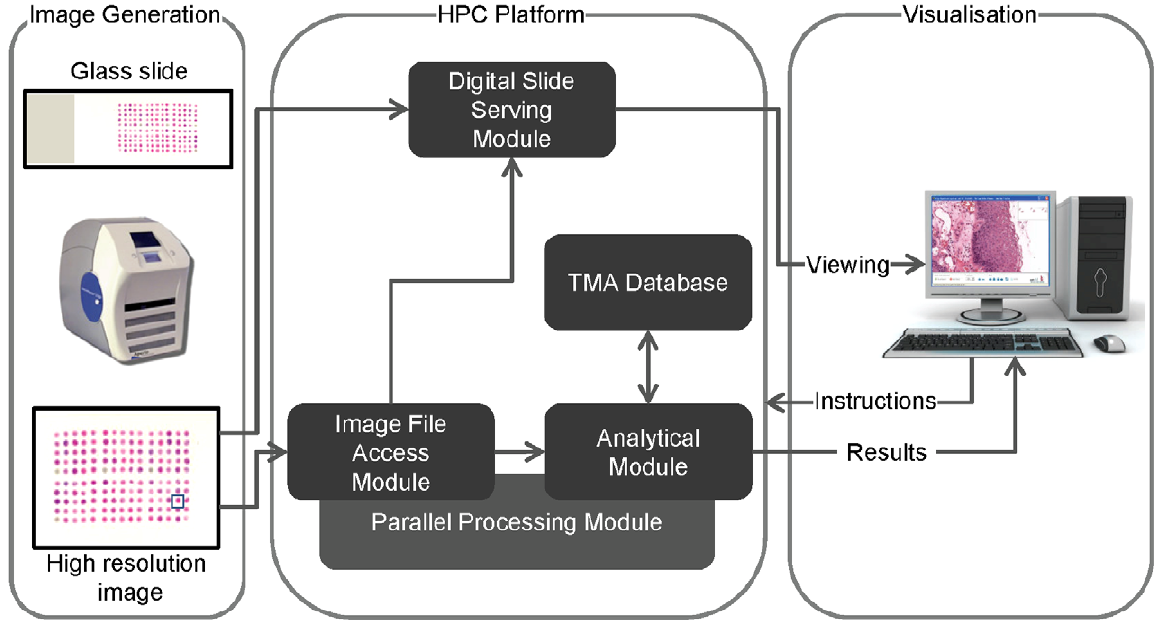
Fig. 1. System architecture of the HPC Platform for TMA Analysis. Image Generation (left) utilises scanning technology to generate high resolu- tion images of the glass TMA slide. This is utilised within the HPC Platform (centre) which comprises a number of interacting functional modules. Visualisation (right) of imagery and data generated from HPC analysis can be achieved remotely used web-based technology based on PathXL platform (i-Path Diagnostics Ltd.). (Colours are visible in the online version of the article;